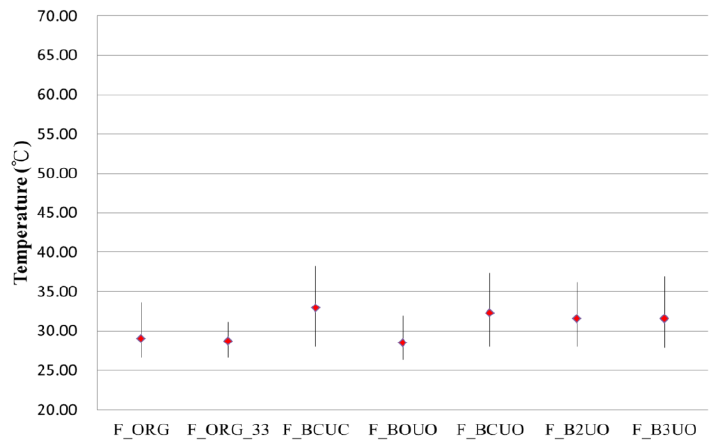
Figure 12. Temperature variations from 60 s to 240 s at Point D (at a height of 1.8 m).